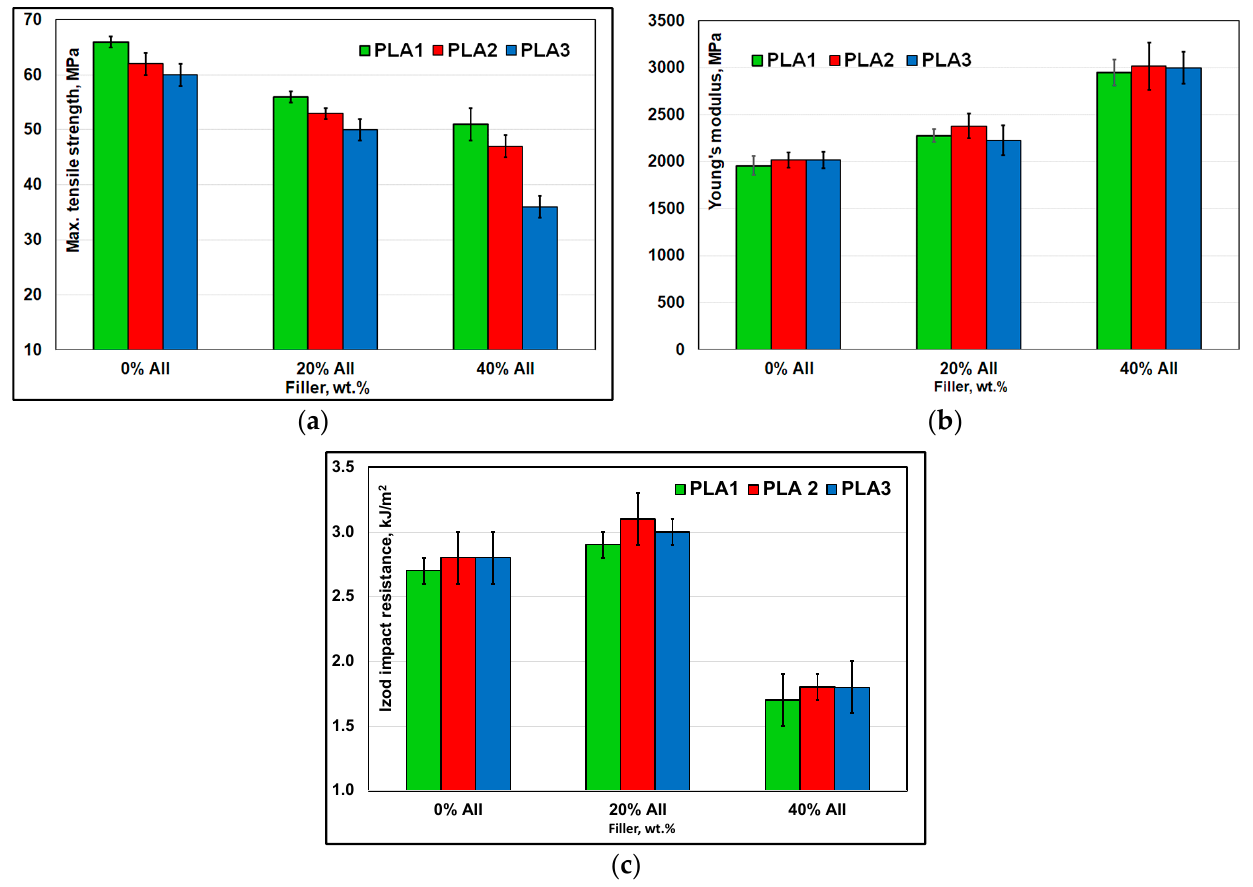
Figure 11. ( a – c ). Comparative mechanical characterizations of PLAs with different amounts of filler: ( a ) Maximum tensile strength; ( b ) Young’s modulus; ( c ) Izod impact resistance (notched specimens).